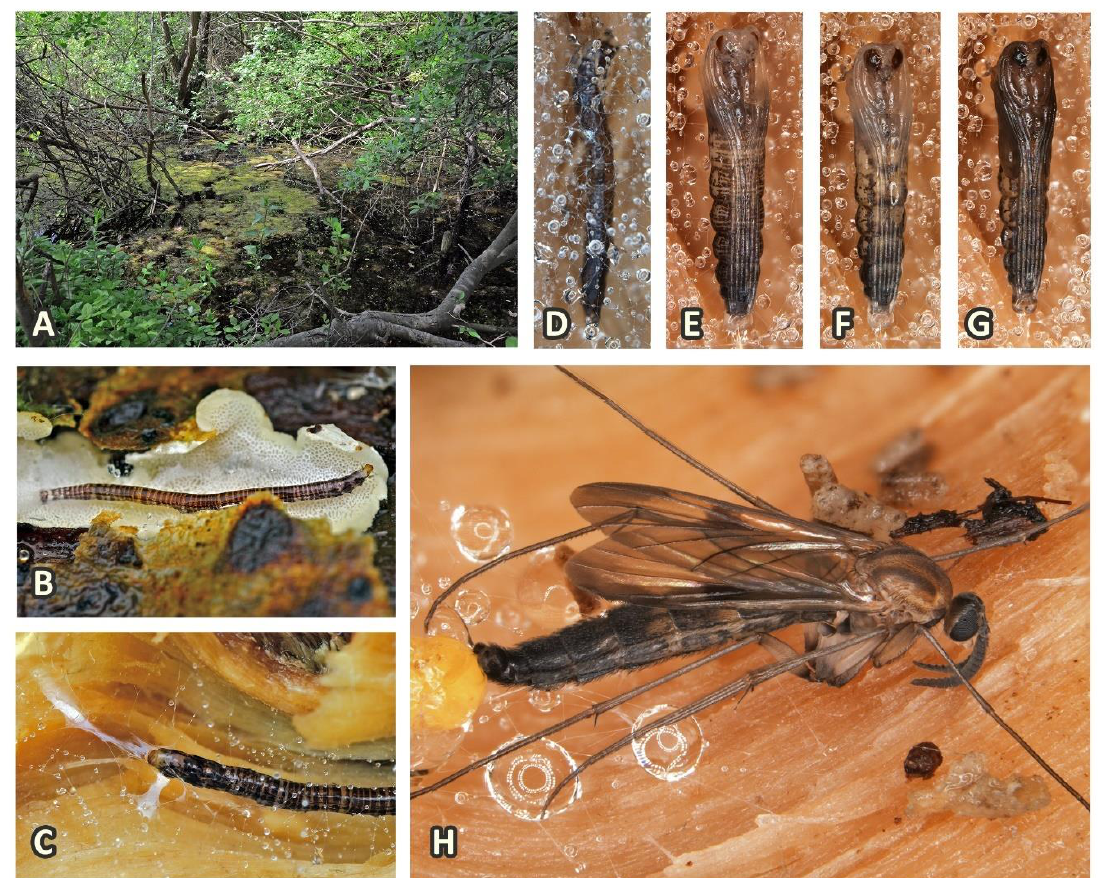
Figure 2. Biology and immature stages of Keroplatidae. This example follows a larva of Cerotelion striatum (Gmelin, 1790) through pupation to hatching. ( A ) Larval habitat in swampy shrubs of Salix caprea inside a limestone quarry in southern Sweden in early June 2012; ( B ) Larva feeding on an unidentified wood-growing fungus on a decaying Salix caprea branch partly submerged into water; ( C ) The larva net-spinning and moving around inside a web on the branch; ( D ) Pre-pupation took place under a dense web; ( E – G ) Daily photos of pupal maturing; ( H ) The adult male hatched only five days after pupation. All photos by J. Kjæ randsen.